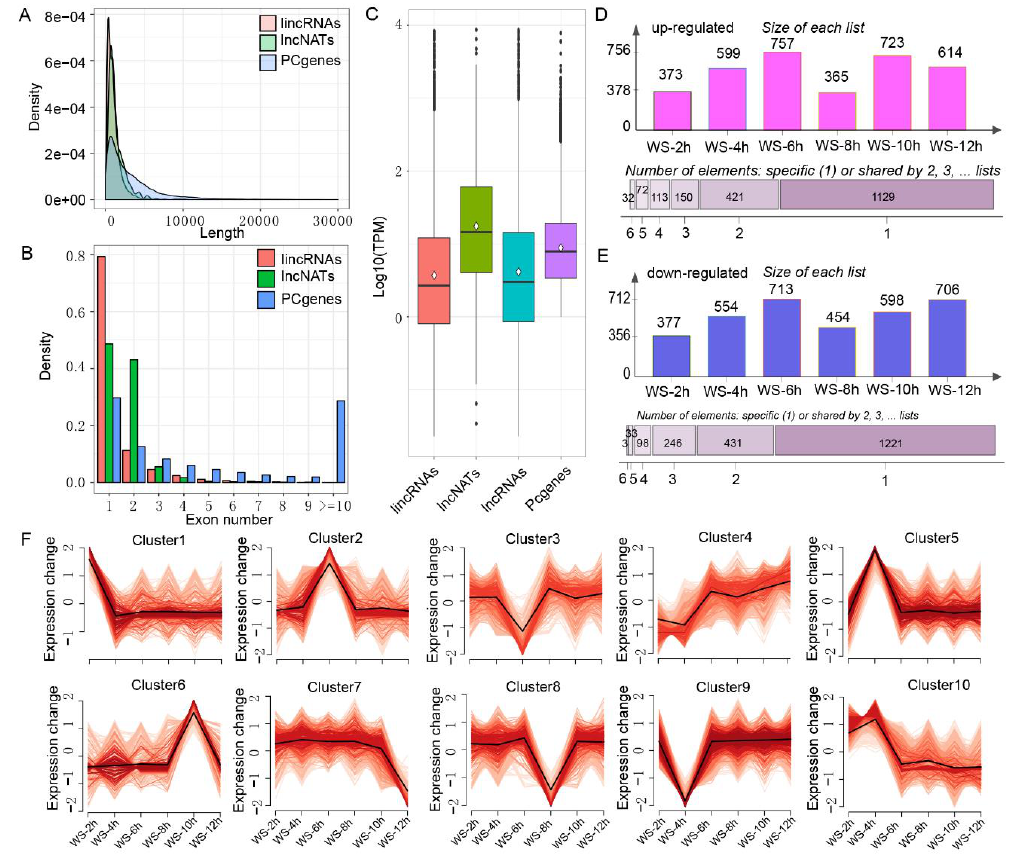
Figure 3. Characterizations of long non-coding RNA (lncRNAs) in maize root tips. ( A ) Length density distributions of long intergenic non-coding RNAs (lincRNAs), long non-coding natural antisense transcripts (lncNATs), and protein-coding genes (PCgenes). ( B ) Distributions of exon numbers in lincRNA, lncNATs and PCgenes. ( C ) The boxplot shows the expression level of lincRNAs,